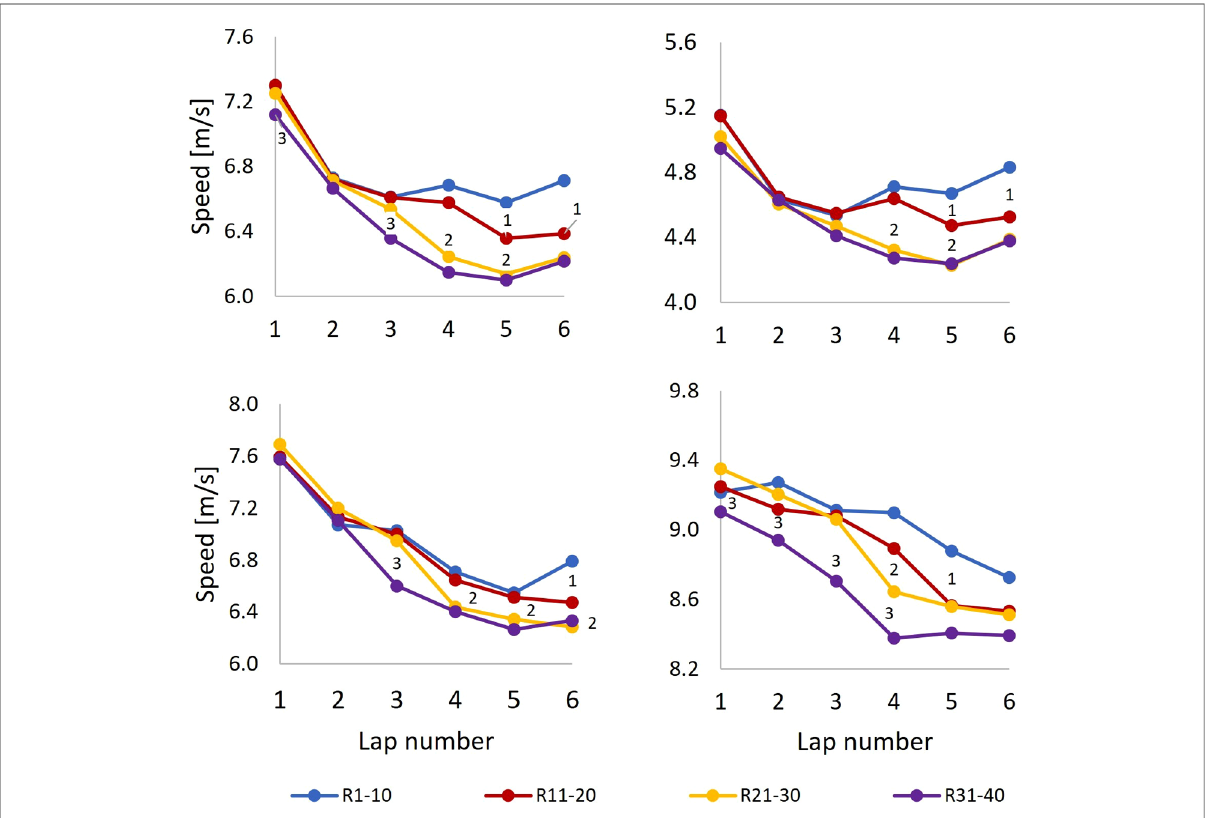
FIGURE 7 Average speed for full lap, uphill, fl at, and downhill terrains as a function of lap-number for the performance-groups during a 21.8 km cross-country skiing mass-start competition. Note that Lap 1 was shorter than the other laps so speed for Lap 1 cannot be compared directly to speed on the following laps. Signi fi cant differences in corresponding speed-values between performance-groups are visualised in the fi gure. R1 – 10 (group 1) denotes ranks 1 – 10, R11 – 20 (group 2) ranks 11 – 20, R21 – 30 (group 3) ranks 21 – 30, and R31 – 40 (group 4) ranks 31 – 40. “ N ” on the plots denotes that speed-value for current group was signi fi cantly different from group N